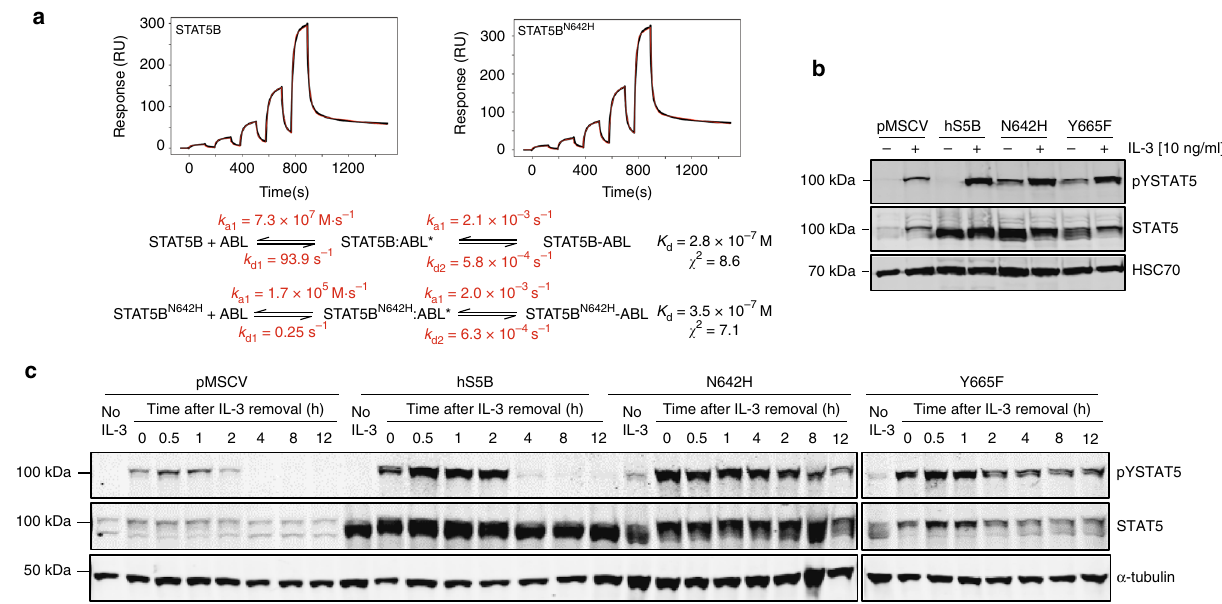
Fig. 8 In vitro and in cellulo STAT5B/STAT5B N642H phosphorylation and dephosphorylation. a SPR analysis of immobilized His-ABL1 kinase with increasing concentrations of either STAT5B or STAT5B N642H . The binding pro fi le was fi t to a two-state model with and the appropriate rate constants are shown. b Ba/F3 cells stably expressing human STAT5B, STAT5B N642H , STAT5B Y665F , or empty vector (pMSCV) were starved of IL-3 for 12 h and were then stimulated with 10 ng mL − 1 IL-3 for 30 min. Activated, tyrosine phosphorylated STAT5 (pYSTAT5) and total STAT5 levels were analyzed by immunoblotting, and detection of HSC70 was performed as a loading control. c To assess phosphorylation kinetics, Ba/F3 stable cell lines described above were starved of IL-3 for 12 h (no IL-3) and were then stimulated with 10 ng mL − 1 IL-3 for 30 min (0 h). Cells were subsequently washed to remove IL-3 and collected at various time points (0.5 – 12 h). pYSTAT5 and total STAT5 levels were analyzed by immunoblotting, and detection of α -tubulin was performed as a loading control. Blots are representative of two independent experiments. Source data are provided as a Source Data fi